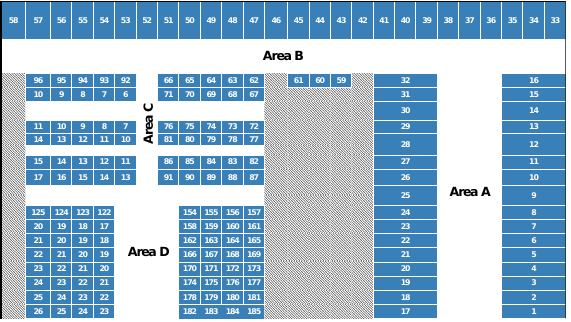
Figure 2. Layout of the warehouse in our case